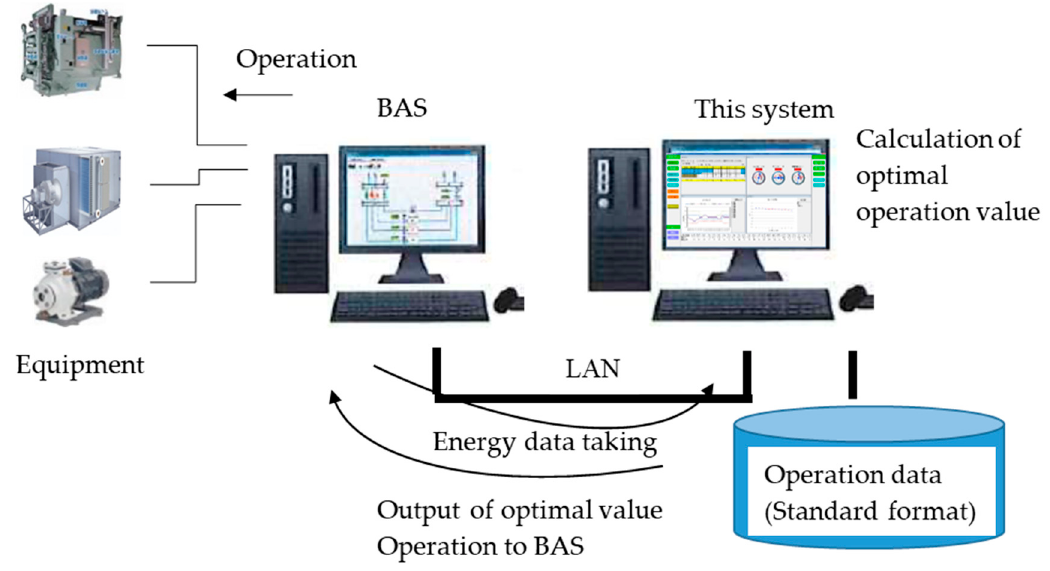
Figure 1. System configuration.